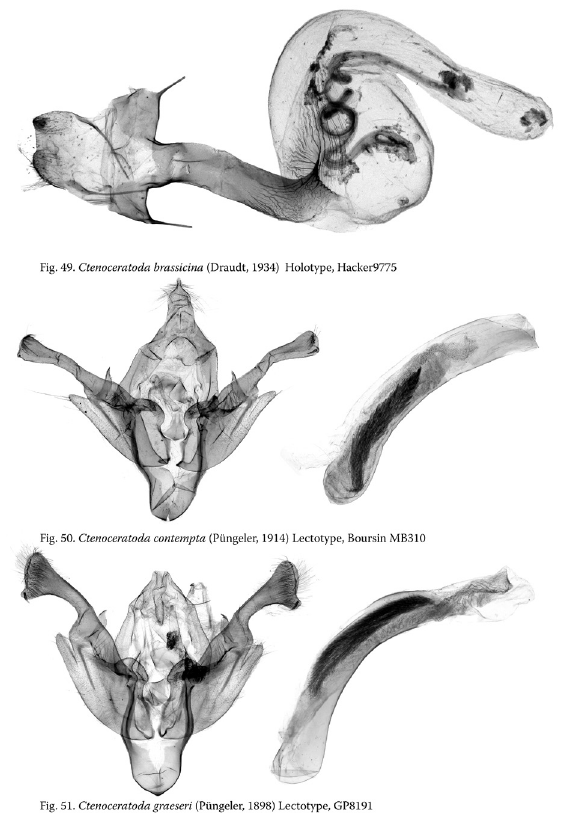
Figure 52–54. 52. Ctenoceratoda longicornis (Graeser, 1892) Lectotype male. 53. Ctenoceratoda longicornis (Graeser, 1892) Paralectotype male. 54. Ctenoceratoda lupa (Christoph, 1893) Lectotype